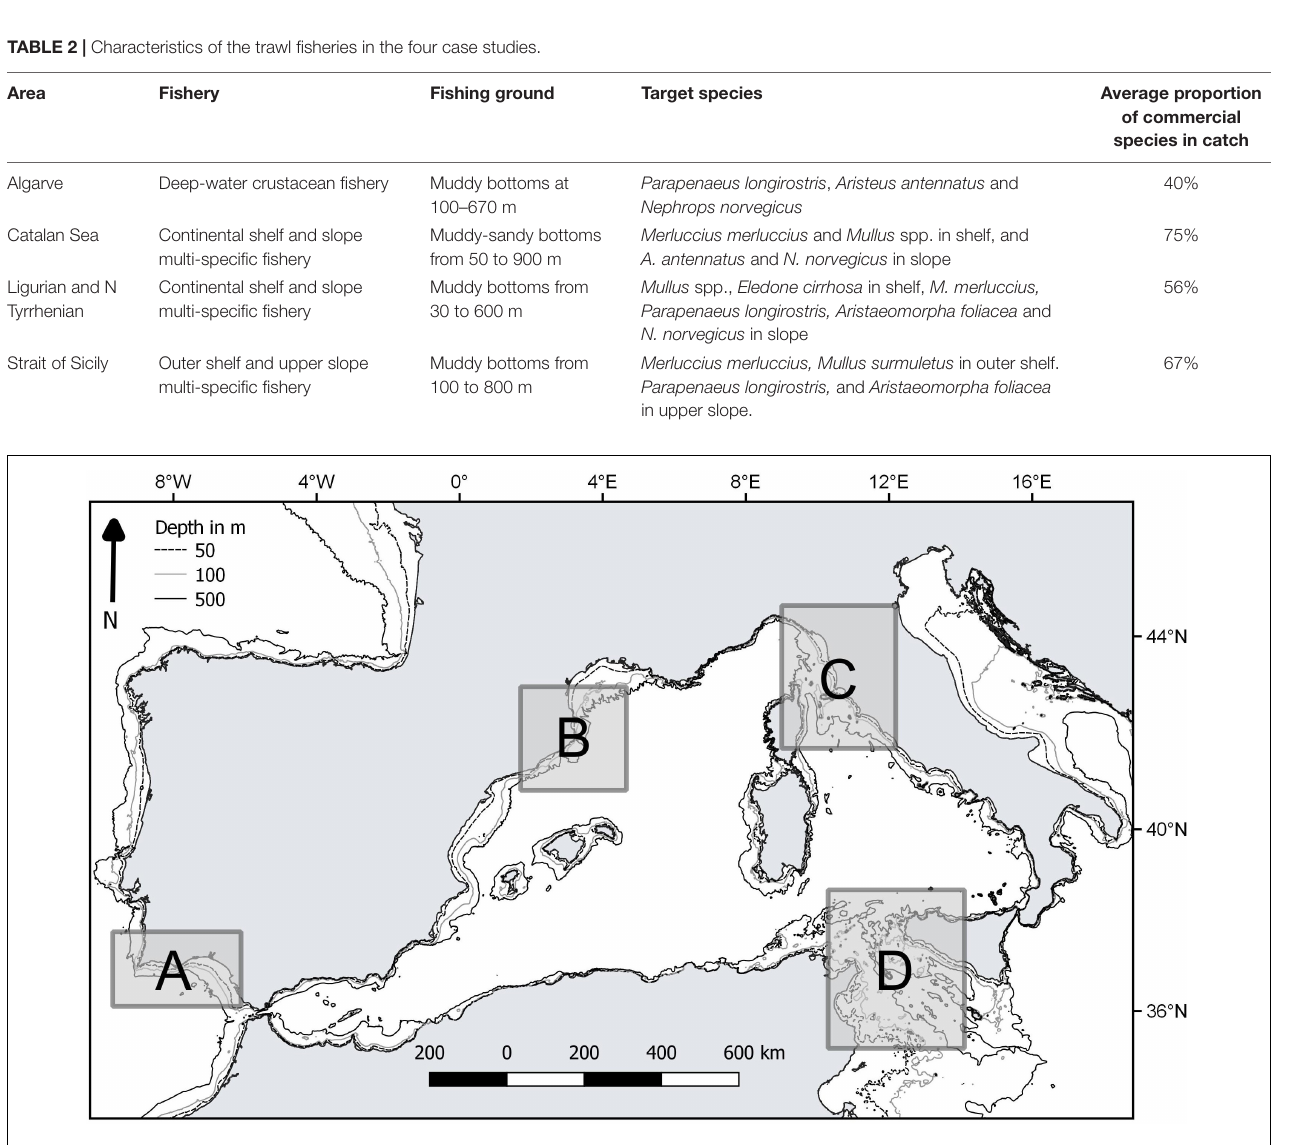
FIGURE 1 | Location of the case studies: A, coast of Algarve; B, Catalan Sea; C, Ligurian and north Tyrrhenian Sea; D, Strait of Sicily.